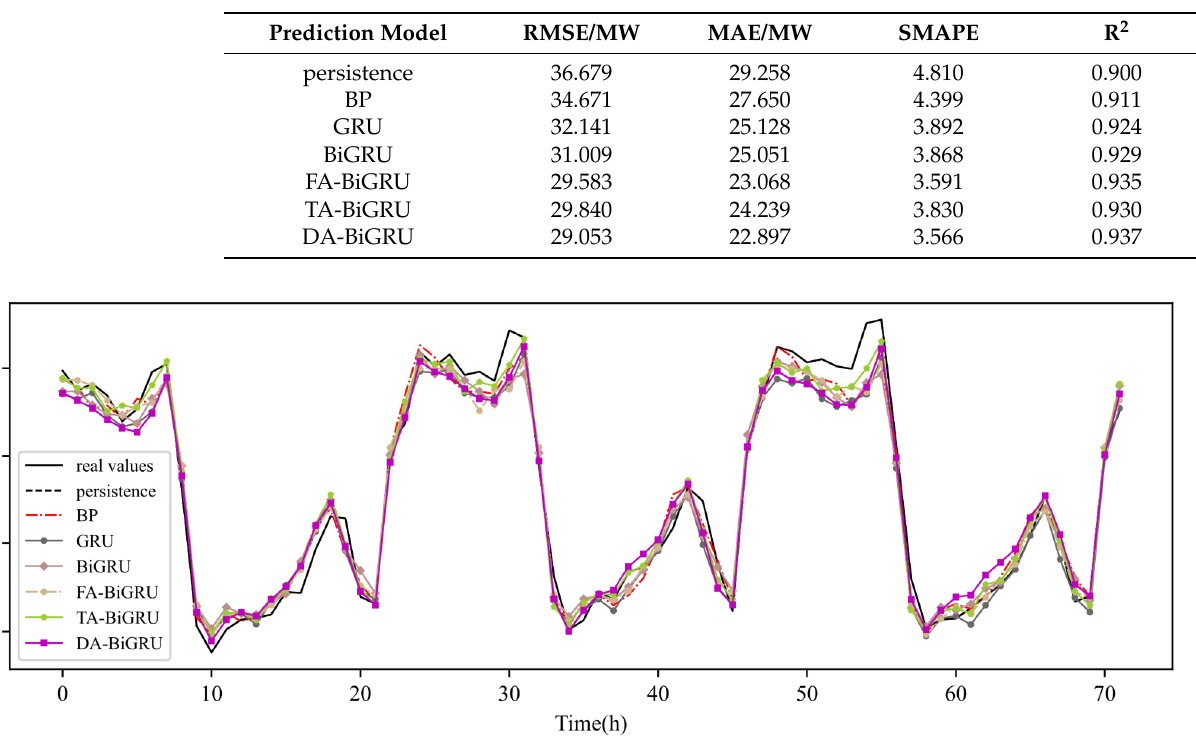
Table 1. The experiment results of case study 1.